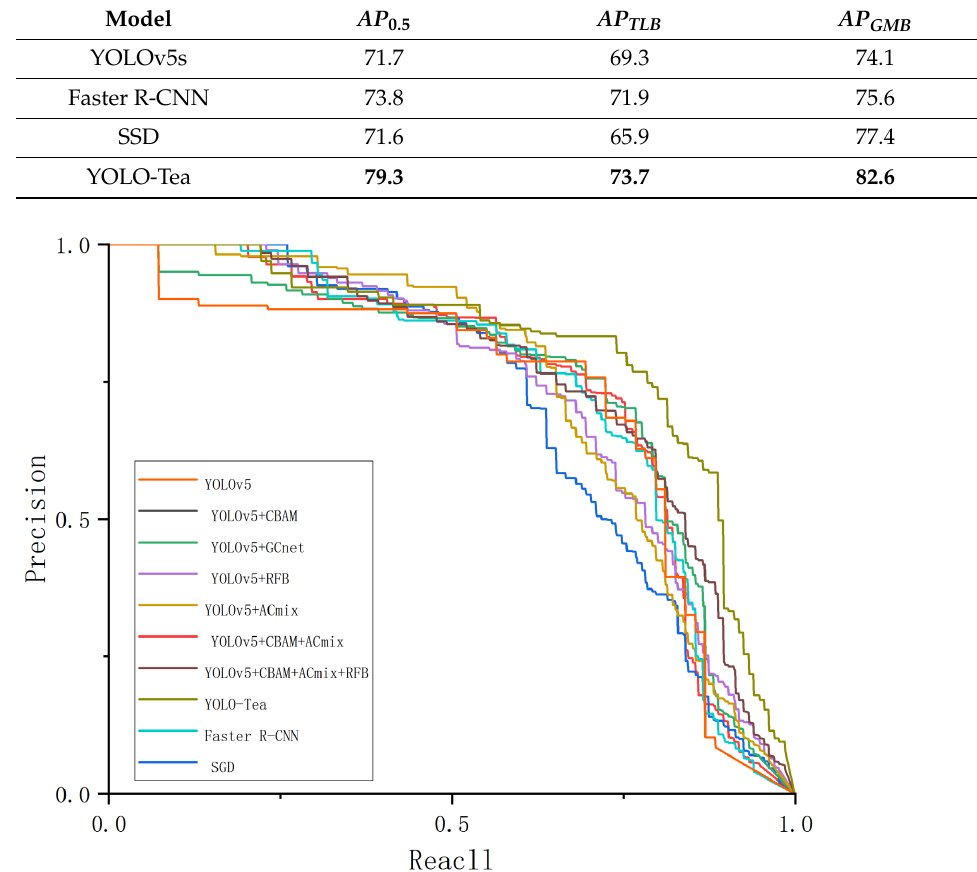
Figure 8. The precision–recall curves of the results. Table 7. The data of resource consumption